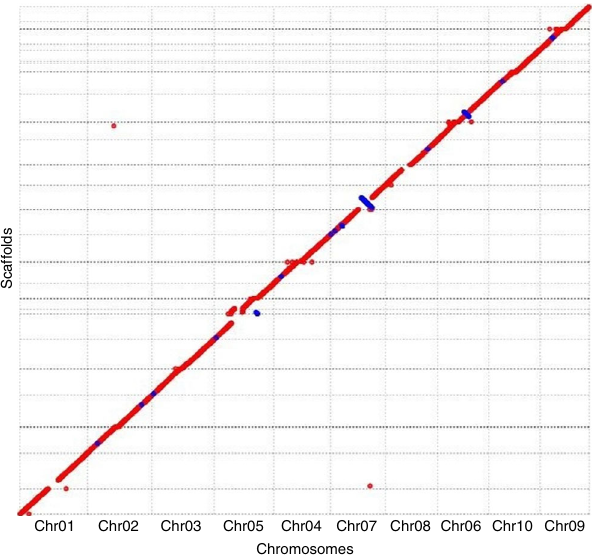
Fig. 3 MUMmerplot comparison of Tx430 hybrid scaffolds with the reference BTx623 assembly. Hybrid scaffolds ( Y -axis) were aligned to all 10 BTx623 chromosomes ( X -axis) using NUCmer and alignments were subsequently fi ltered for 1-on-1 alignments and rearrangements with a 20 Kbps length cutoff. Chromosome order on the X -axis is related to the alignment of Tx430 scaffolds mapping to more than one